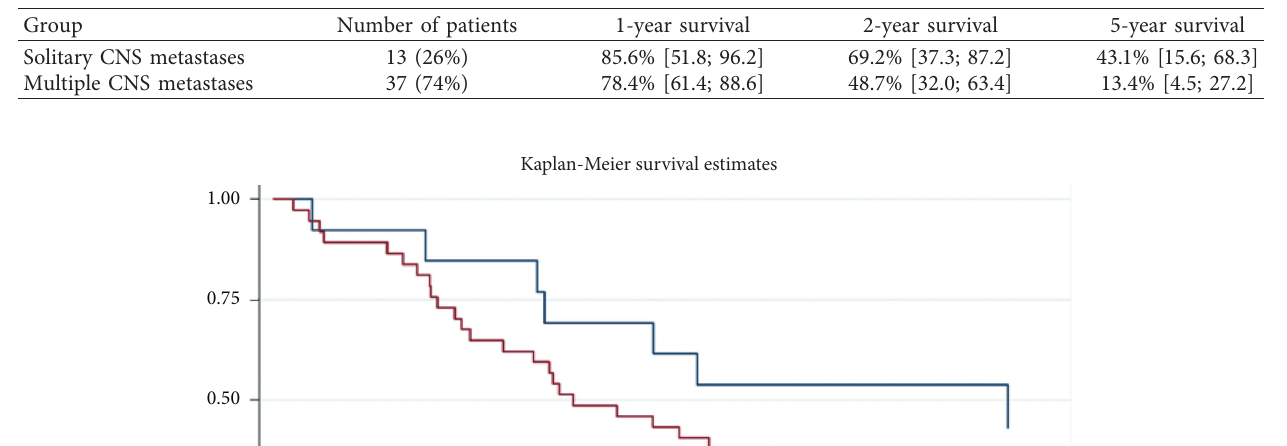
Table 5: Survival results depending on the number of the metastases.